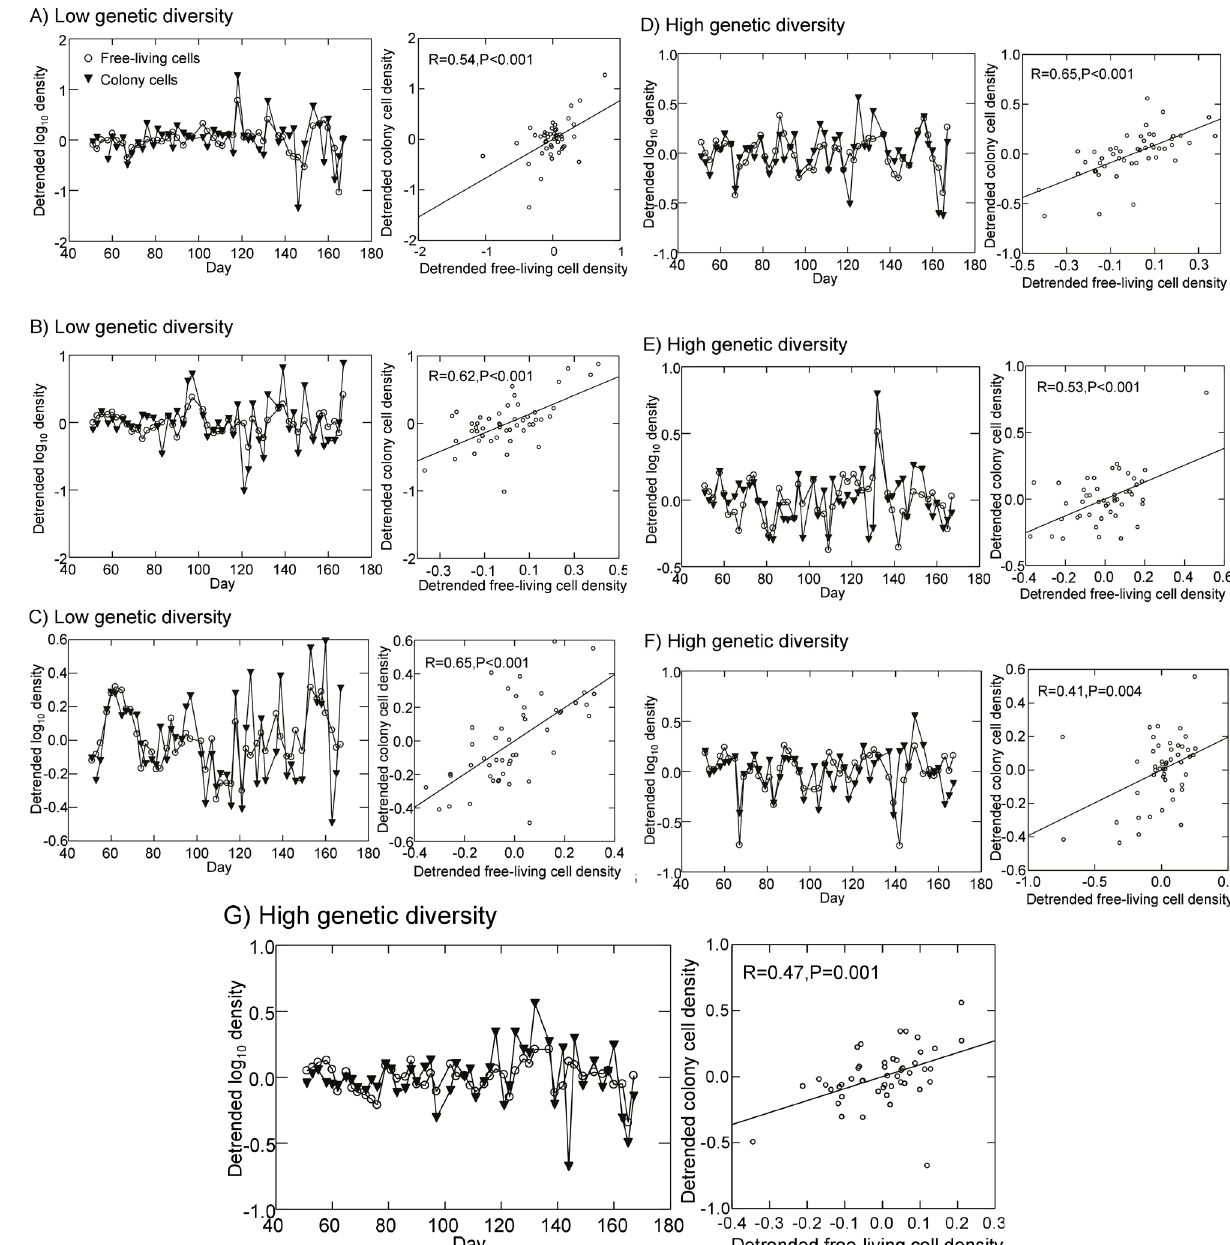
Figure 10. Detrended dynamics of Synura free-living cells and colony cell abundances in the presence of Brachionus (left panels) for all three replicates of the low genetic diversity treatment ( A – C ) and all four replicates of the high genetic diversity treatment ( D – G ). Shown for each replicate in the right panel is the relationship between free-living cell and colony cell abundances and Pearson correlation statistics (the line is the linear regression fit). Detrended abundances are the residuals from linear regressions of either log free-living cell densities or log colony cell densities versus